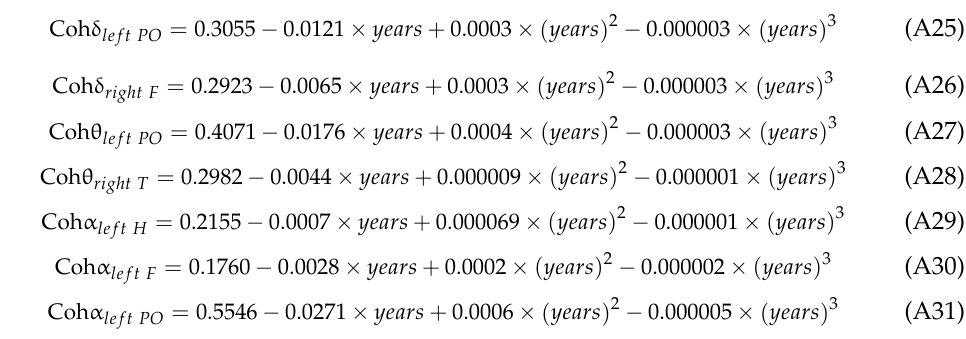
F = frontal; H = hemisphere; PO = parieto-occipital; T = temporal. Quadratic regression functions for synchronization measures fitted by the least-squared method. Only those functions with statistically significant correlation coefficient (r) are